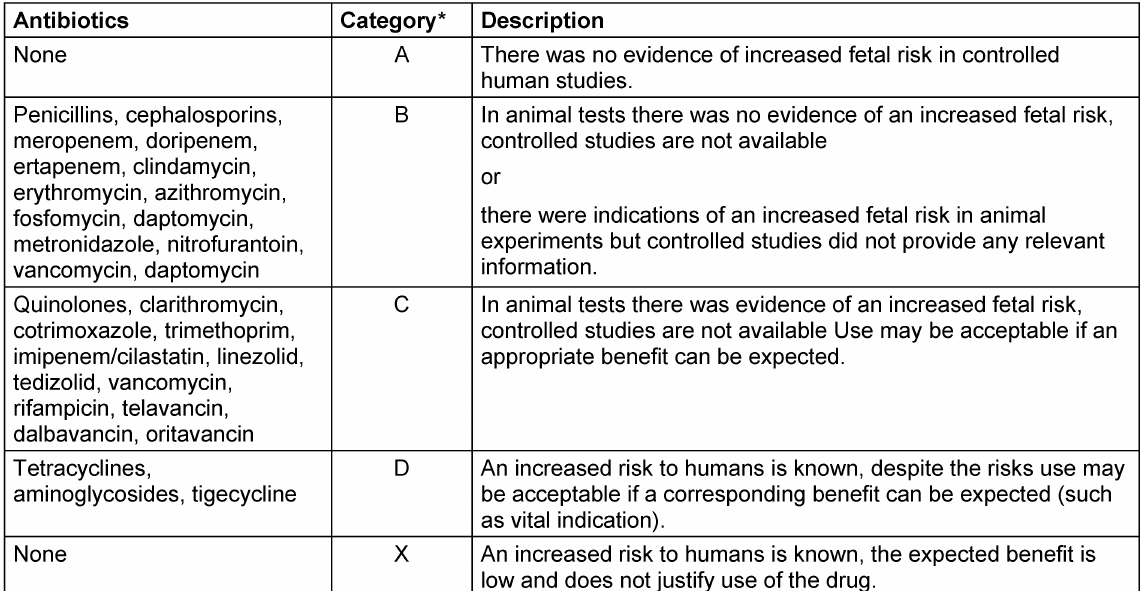
Table 1: Embryo-fetal risks when using